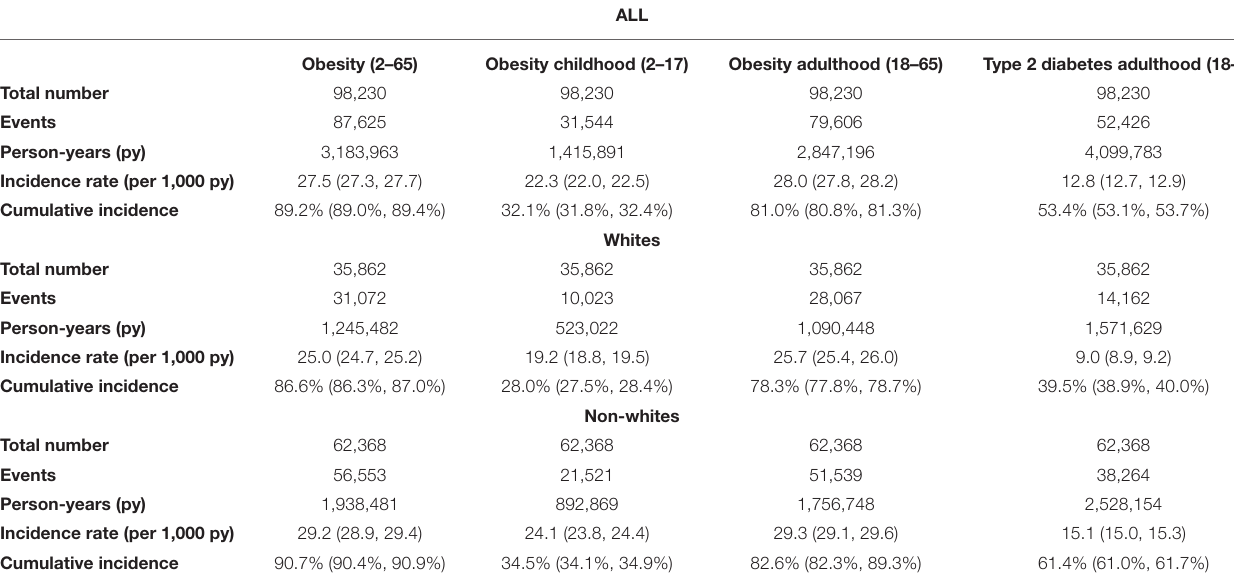
TABLE 1 | Incidence rates and cumulative incidence of obesity and type 2 diabetes in the ViLA-Obesity model ( n =